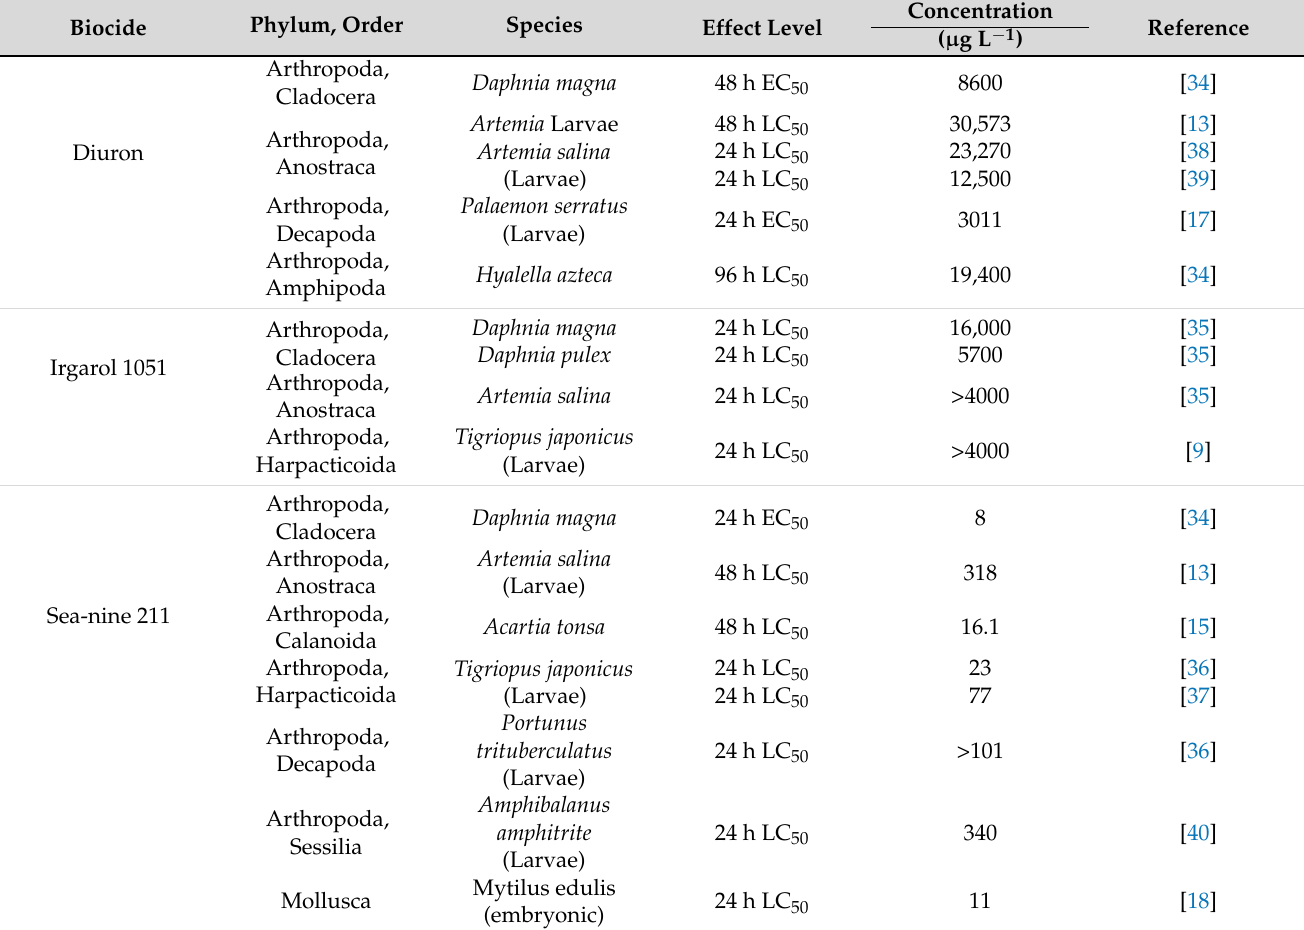
Table 3. LC 50 and EC 50 concentration of three booster biocides (Diuron, Irgarol 1051, and Sea-nine 211) on zooplankton